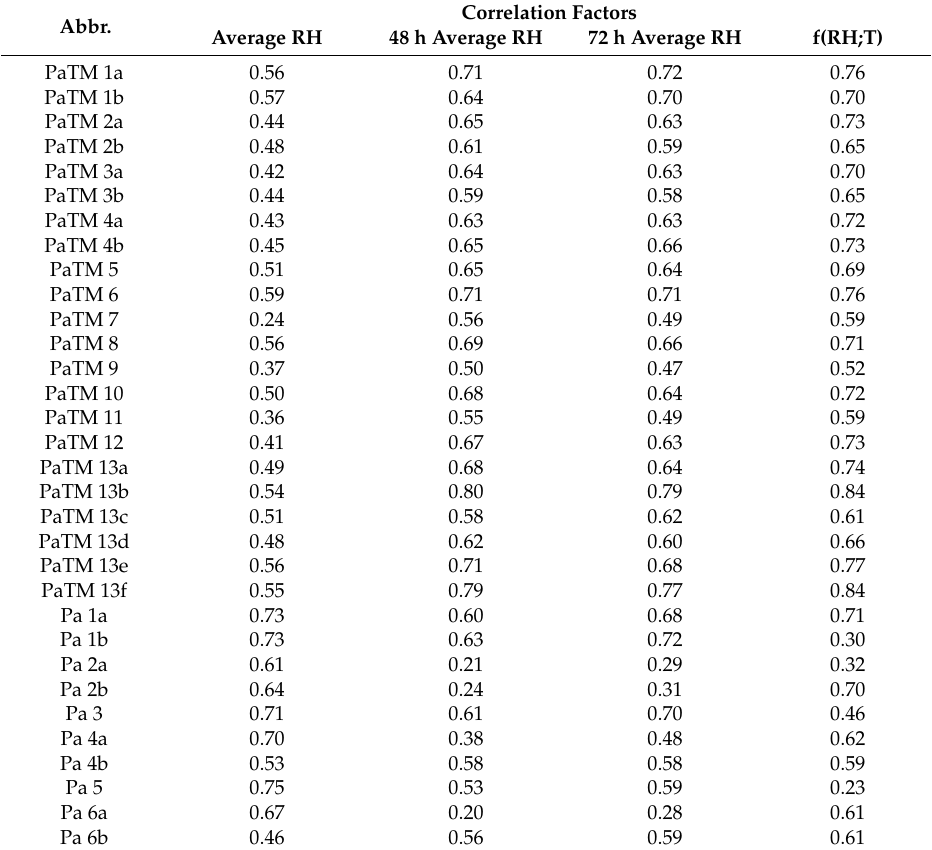
Table 3. Coe ffi cient of correlation between wood MC and selected indicators: Average RH (average RH 12 h before MC measurements), 48 h average RH (average RH 48 h before MC measurements), 72 h average RH (average RH 72 h before MC measurements), f(RH; T) (value calculated according